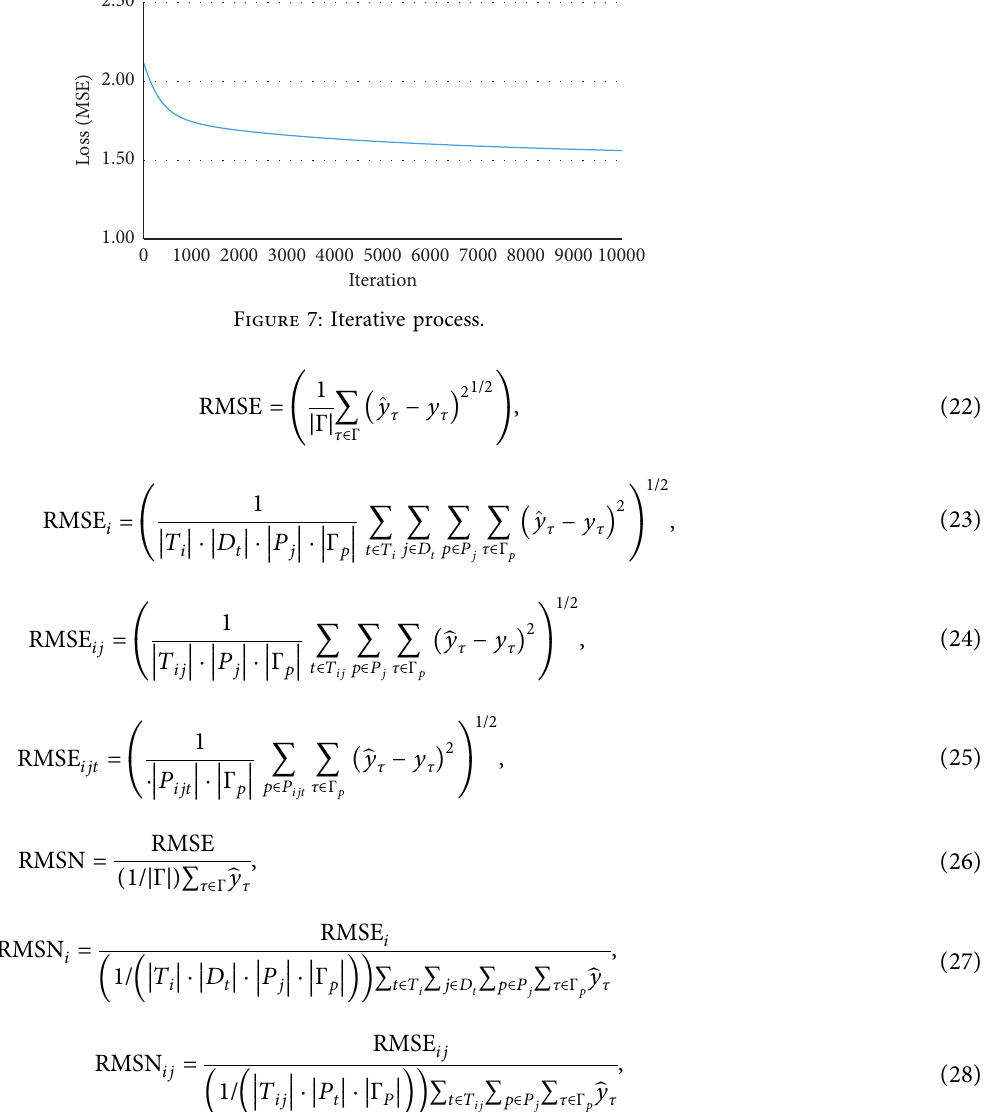
Figure 7: Iterative